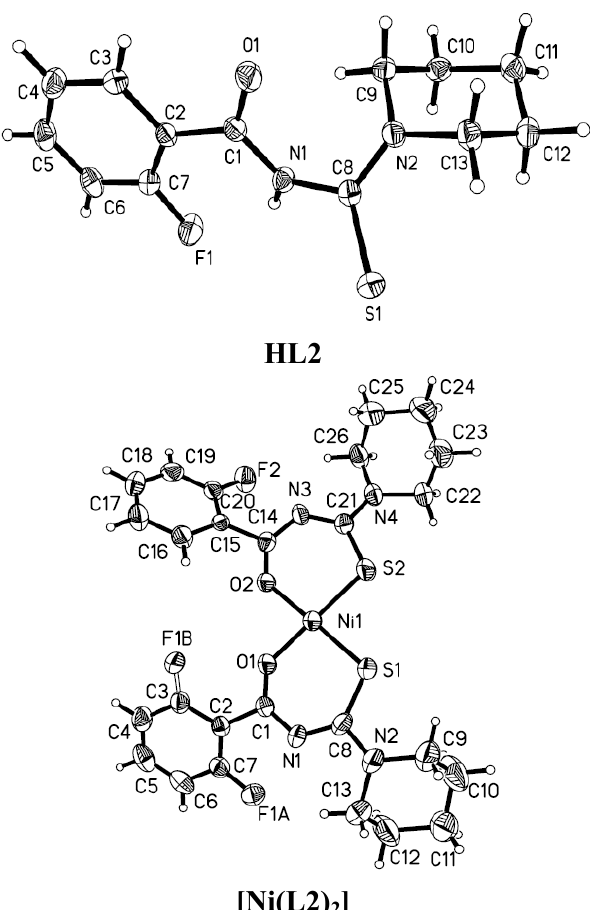
Figure 1. Molecular structures of HL2 and [Ni(L2) 40% probability.